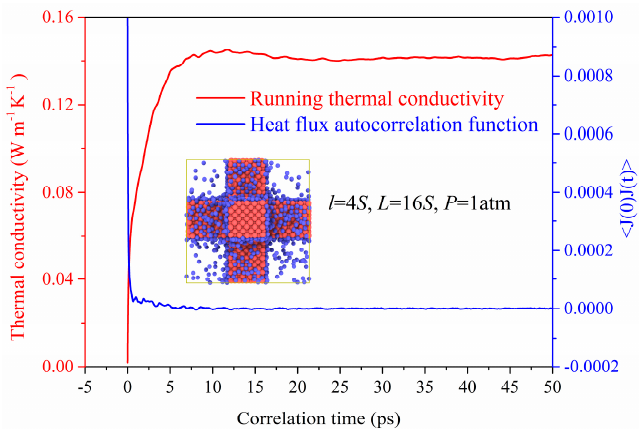
Figure 2. The HFACF and running thermal